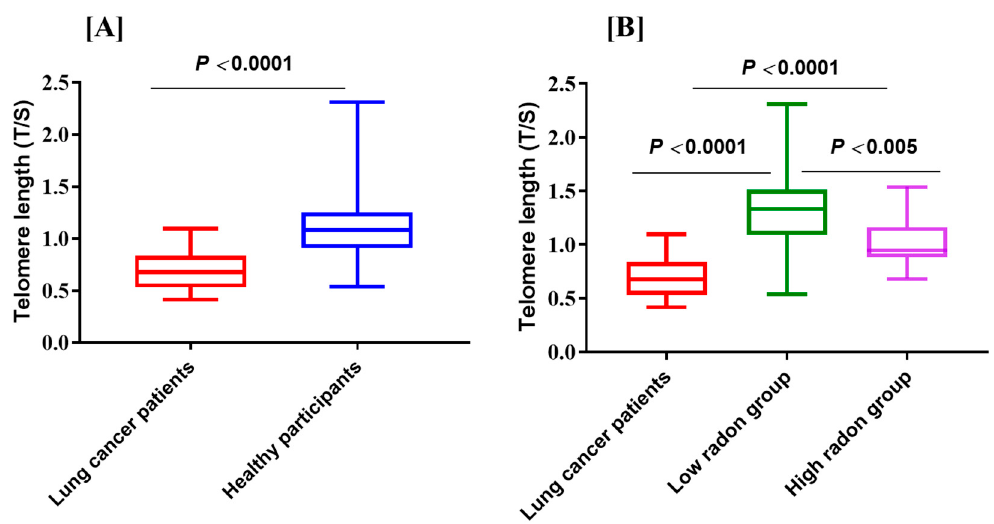
Figure 4. The relative telomere length ( T/S value) in peripheral blood leukocytes in lung cancer patients and healthy controls with respect to low- and high radon areas. ( A ) Short telomere length in lung cancer patients. ( B ) Short telomere length in lung cancer patients as compared with healthy controls with respect to low -and high radon areas.